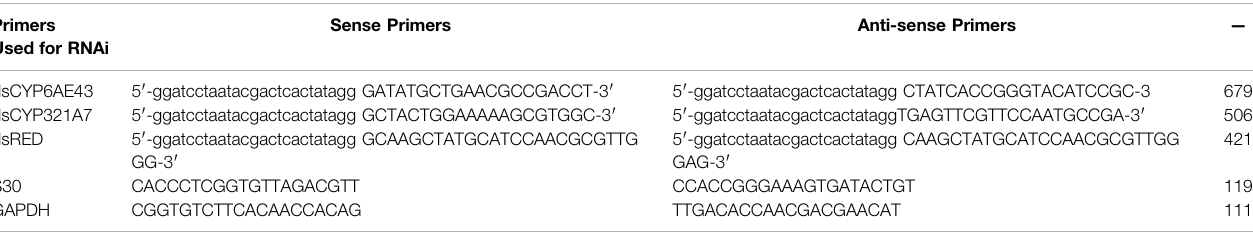
TABLE 1 | Primers used in this study for RNAi. Primers Used for RNAi